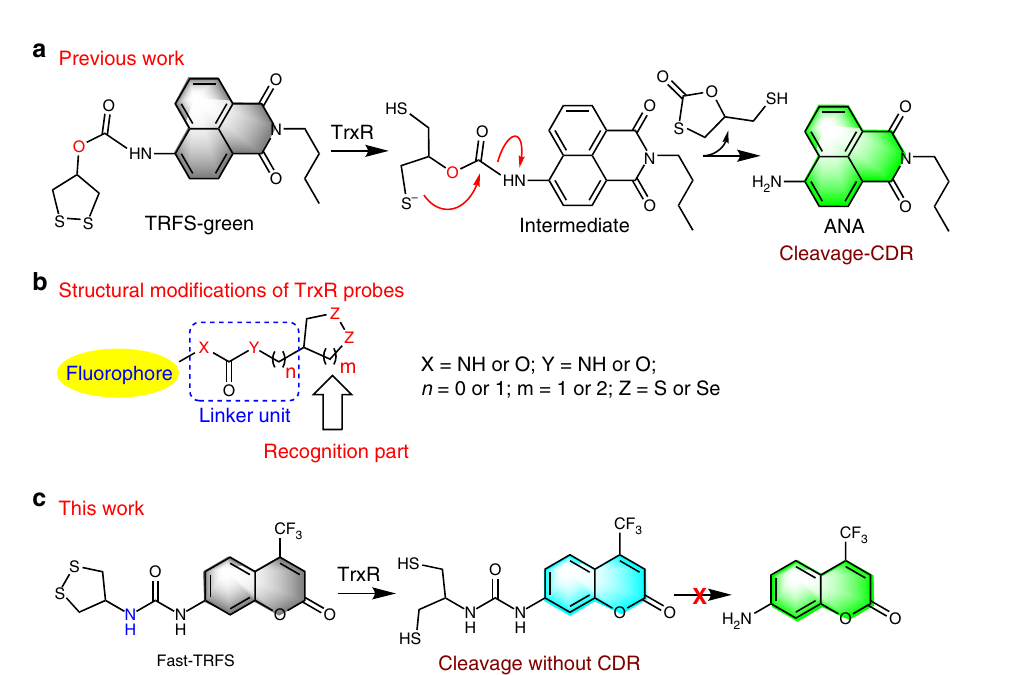
Fig. 1 Reaction mechanism of TRFS-green and summary of current work. a Stepwise activation of TRFS-green. b Strategy for modi fi cation of TRFS-green. c One-step activation of Fast-TRFS